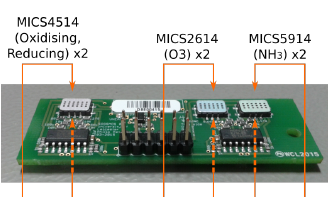
Figure 5. The layout of sensors on an SOGS MOS instrument board. Visible are the side a set of sensors; the second set of sensors b is on the reverse side. The MICS4514 contains two different sensor elements. Table 1. Summary of sensors utilised. Due to the individuality of each gas sensor, the resolution of the measurements could not be provided by the